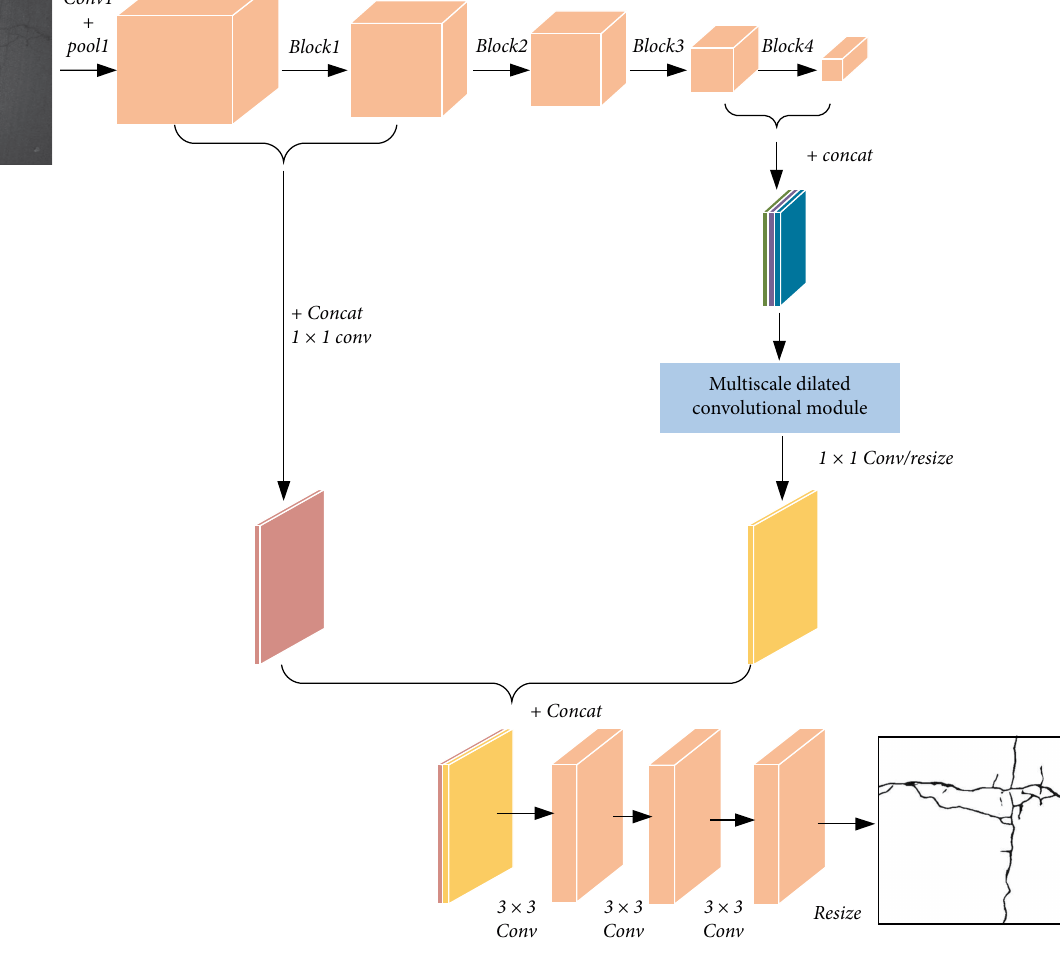
Figure 2: Illustration of the crack detection network, CrackSeg. The multiscale dilated convolution module is used to capture abundant crack features. After fusing with the lower level crack features in the network, three 3 × 3 convolution operations are used continuously to improve the feature expression ability. The output feature of the last convolution layer is the crack feature maps, which is the input into the binary classifier for crack pixel-wise prediction.